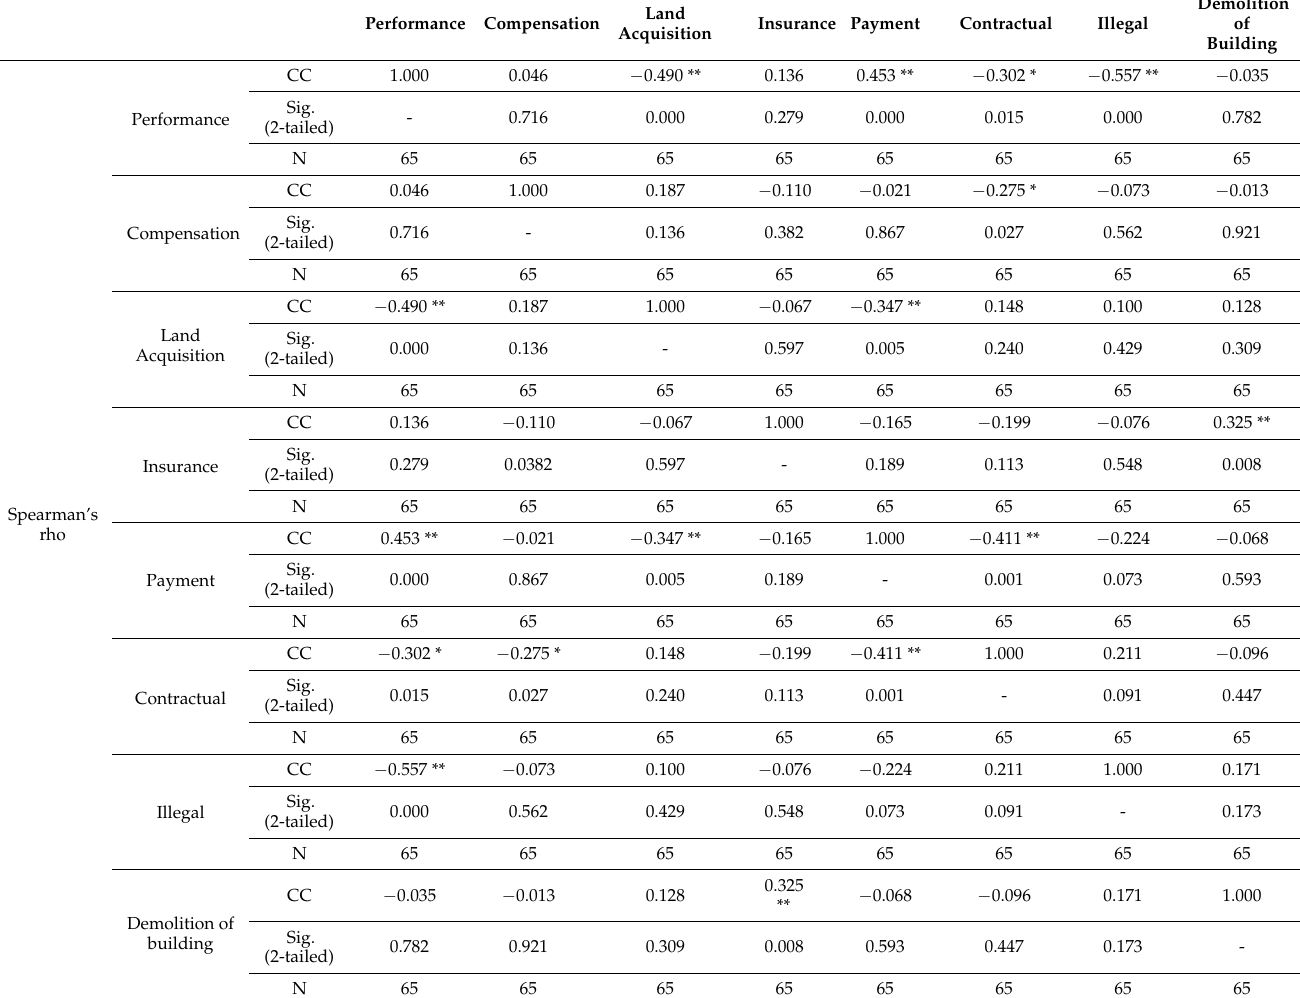
Table 5. Correlation matrix of